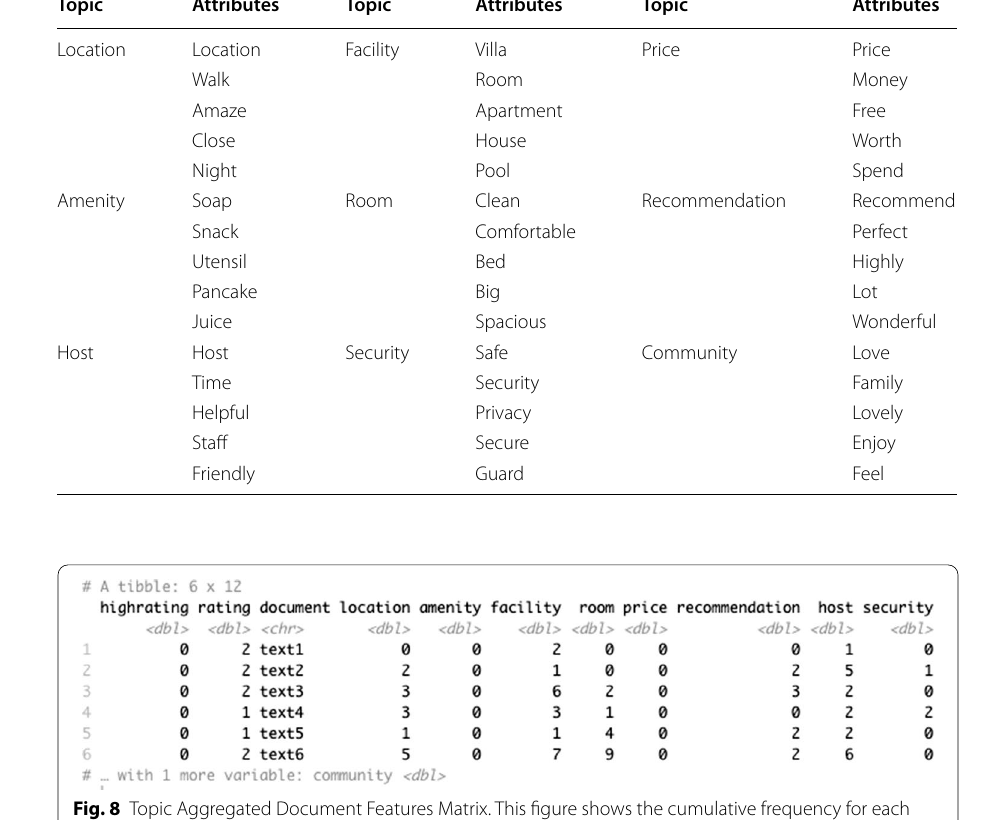
Table 14 Topic distribution and attributes example Topic Attributes Topic Attributes Topic Attributes